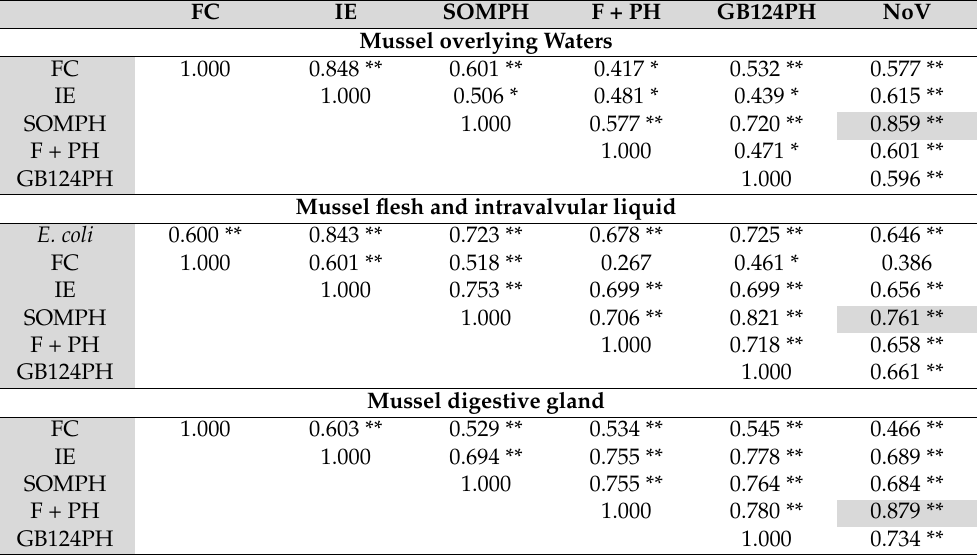
Table 2. Annual correlation coefficients (Spearman’s ρ ) between levels of faecal indicators and Norovirus with respect to mussel sample matrix. IE F +